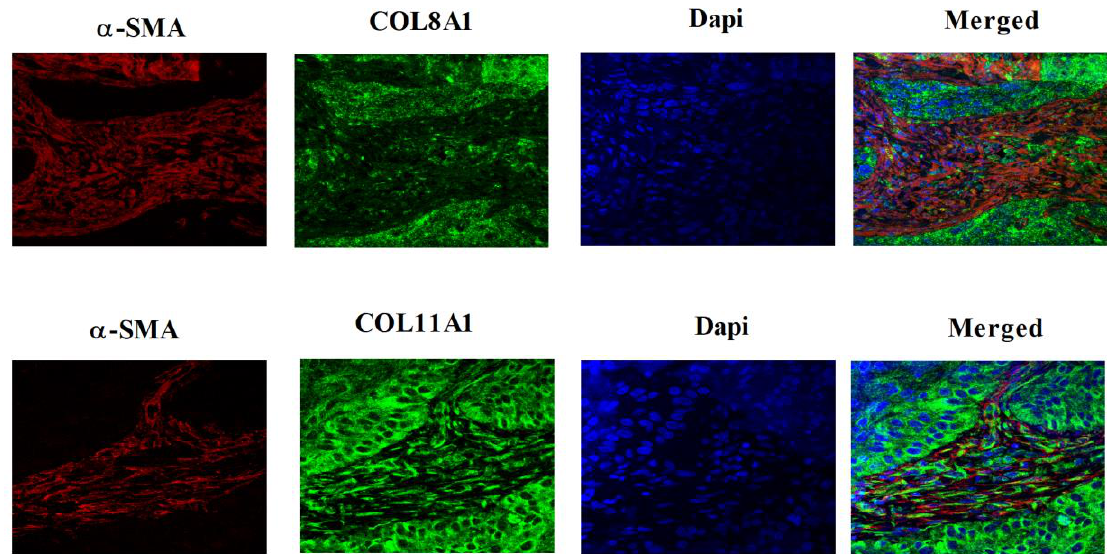
Figure 2. Expression of COL8A1 and COL11A1 in oropharyngeal squamous cell carcinoma (OPSCC). Photomicrographs show expression of COL8A1 (top panel) and COL11A1 (lower panel) in OPSCC tissues. Tissues were multiplex-stained with COL8A1 or COL11A1 (fluorescein, green), together with α-smooth muscle actin (α-SMA) (Cy3, red) antibodies and 4′,6-diamidino-2-phenylindole (DAPI) (blue). The expression of COL8A1and COL11A1 was detected in OPSCCs and cancer-associated fibroblasts. Representative images are shown and were captured with a confocal laser microscope (Zeiss, Carl Zeiss AG, Oberkochen, Germany; magnification × 63). Examples of COL8A1and COL11A1 expression in oral squamous cell carcinoma tissues are shown in Supplementary Figure S2.